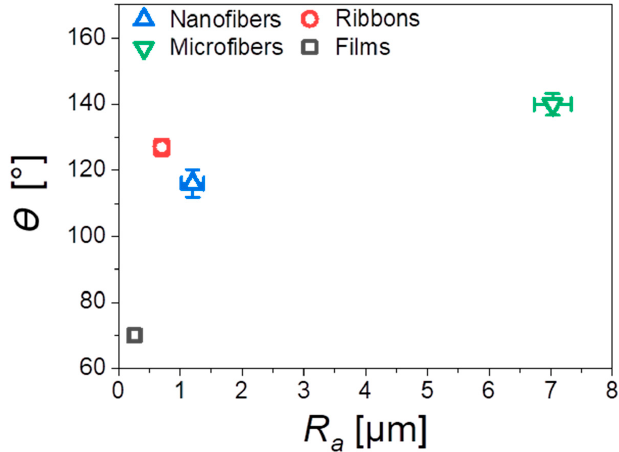
Figure 3. Water contact angles Ɵ as a function of the average roughness, R a, for all investigated PMMA scaffolds and